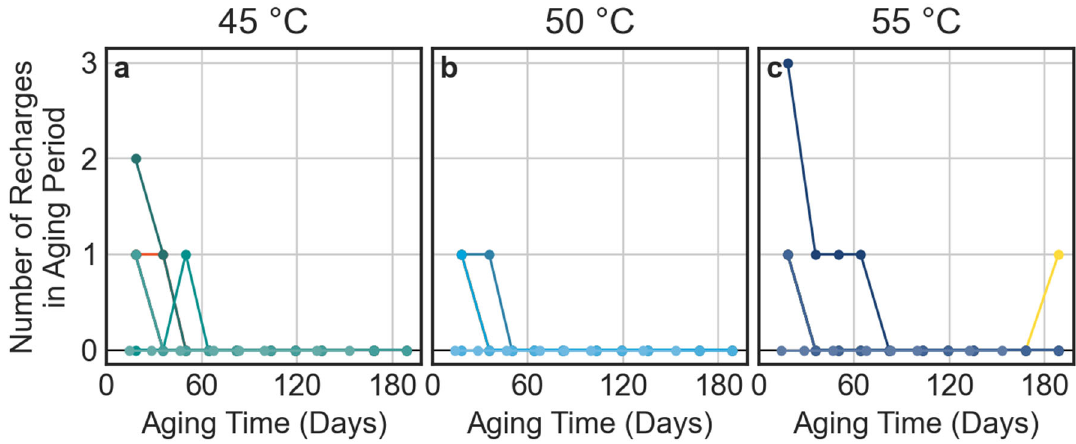
Figure A1. The number of recharges that occurred during each aging